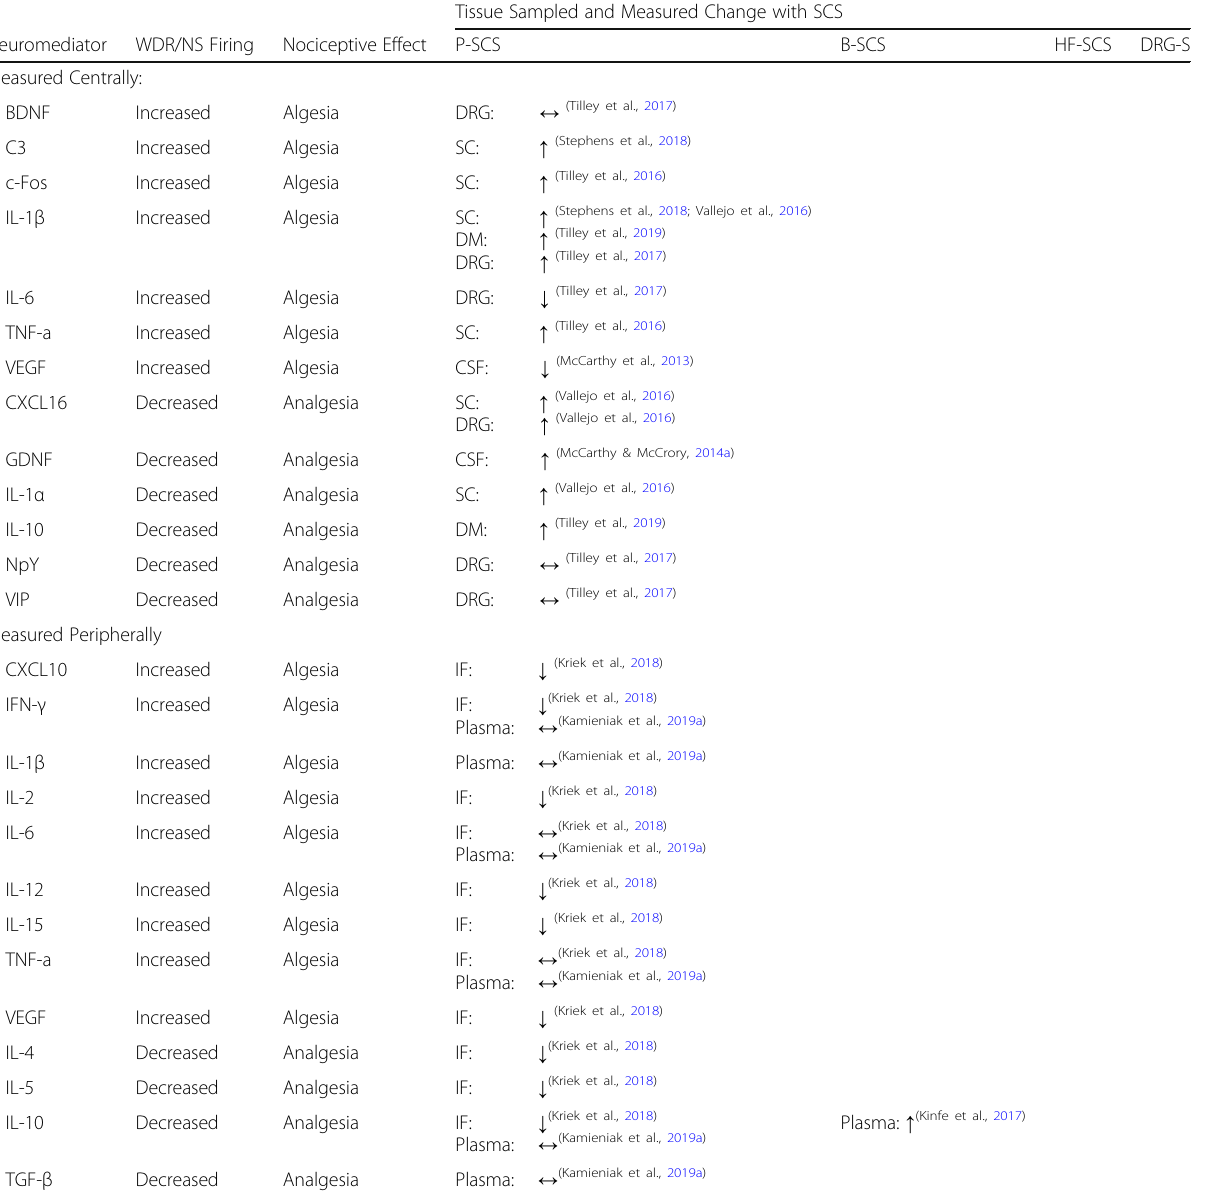
Table 3 Evidence for the response of cytokines and neurotrophic factors to spinal cord stimulation (SCS) paradigms